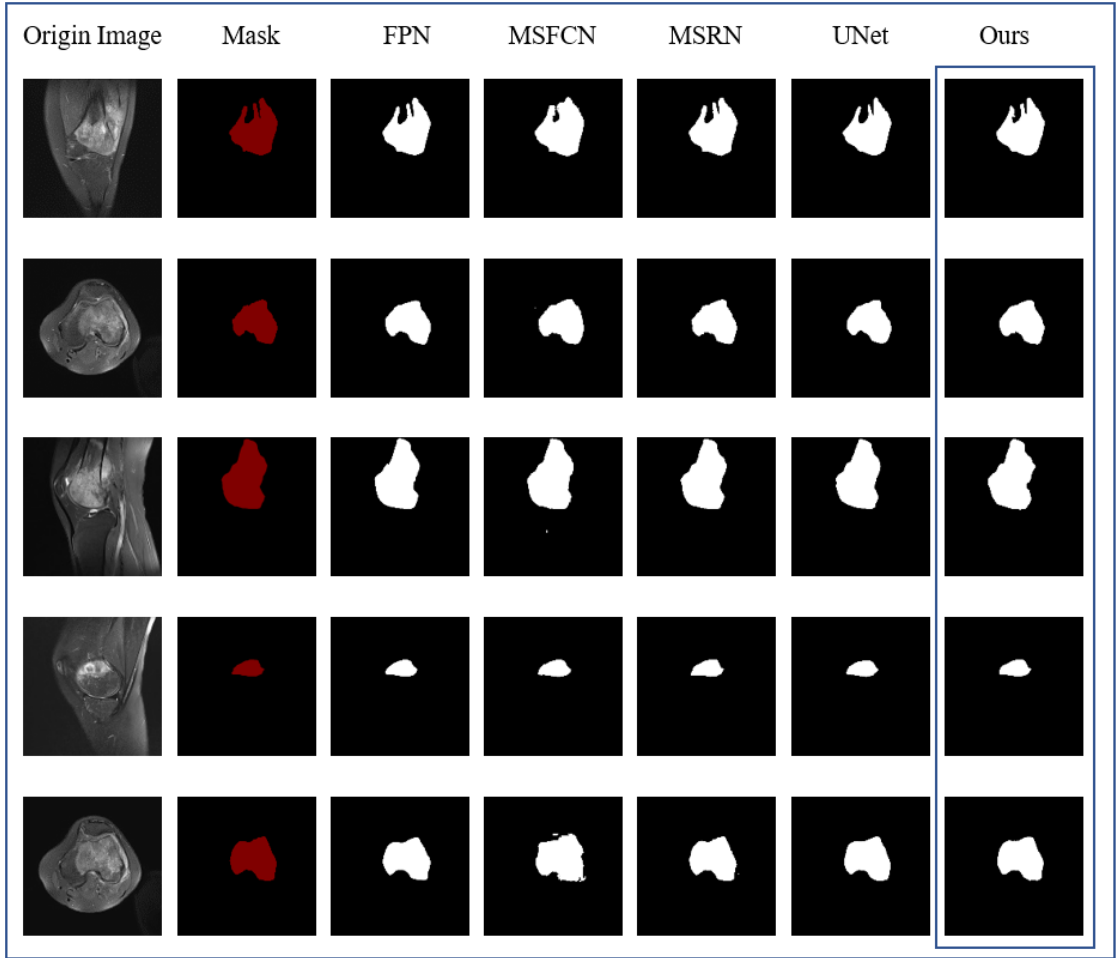
Figure 10. Comparison of segmentation effects of different algorithms. Table 4. Comparison of osteosarcoma segmentation performance of different algorithms.